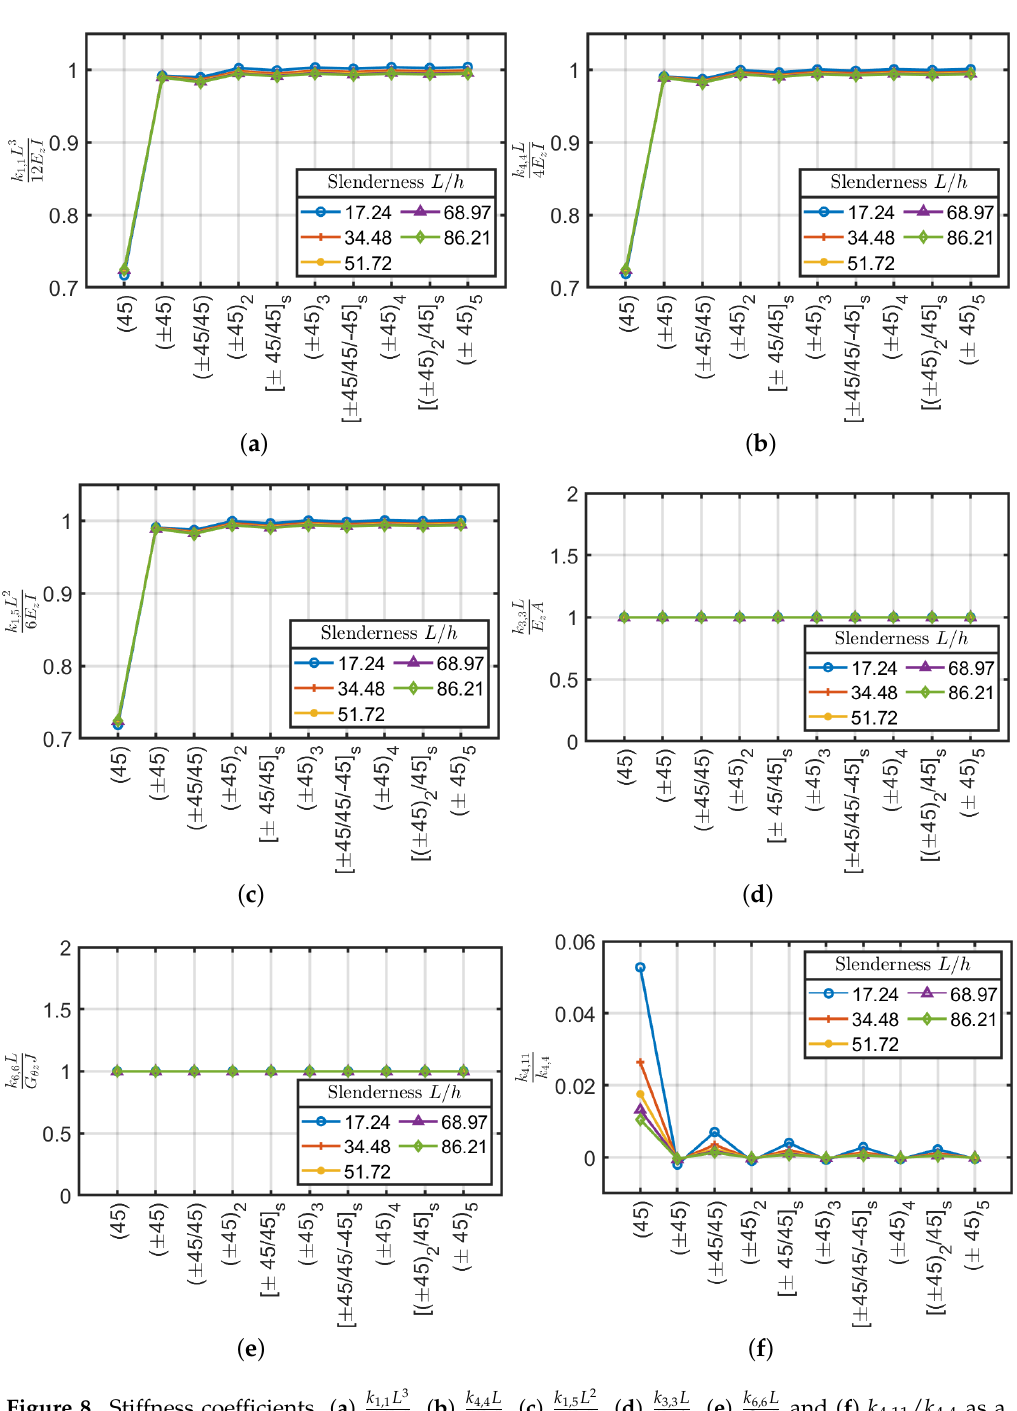
Figure 8. Stiffness coefficients ( a ) k 1,1 L function of slenderness L / h for angle-ply